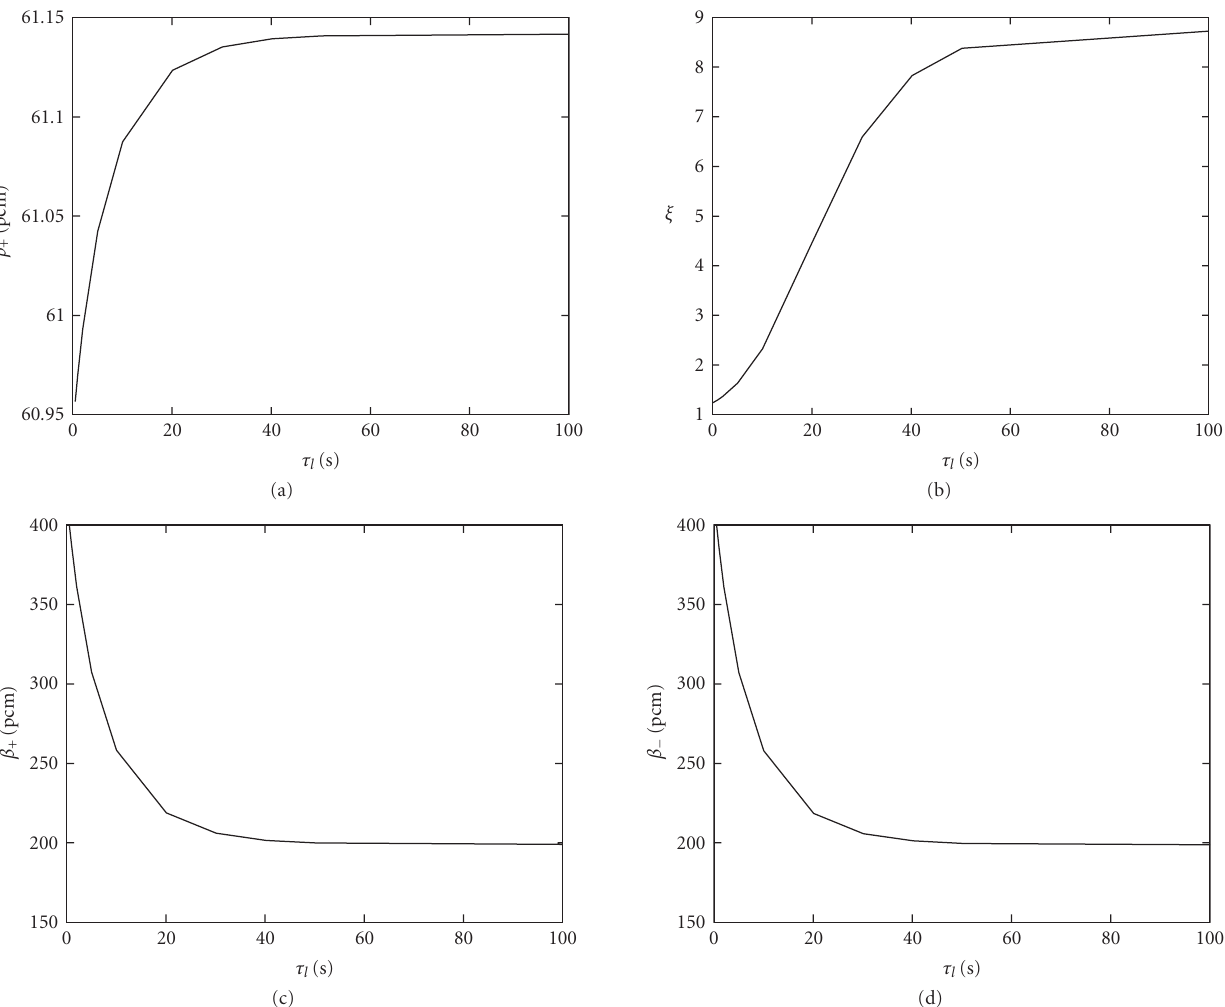
Figure 4: Parametric study of the e ff ect of the recirculation time τ l on the integral parameters regulating the divergence of the power. (a): mean reactivity inserted in the interval τ c ; (b): value of the fundamental eigenvalue ξ ; (c): mean value of (cid:6) β during τ c ; (d): value of (cid:6) β during τ l